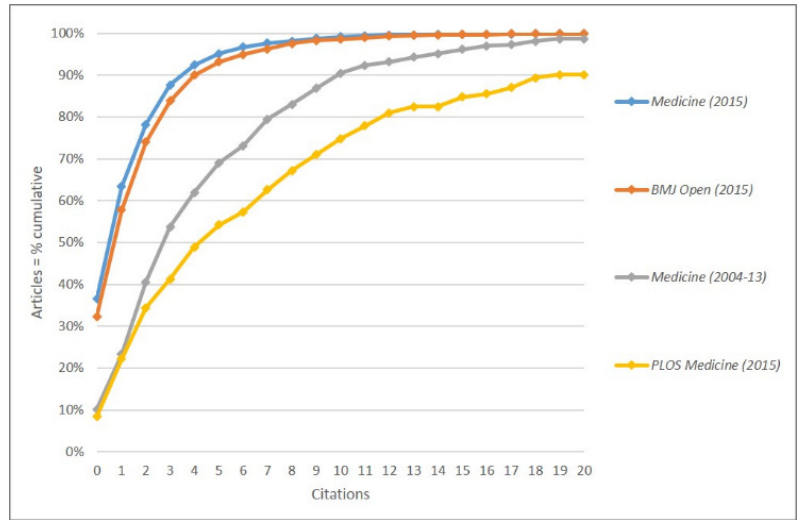
Figure 1. Cumulative citation frequency for Medicine (pre- and post-OAMJ transition), BMJ Open and PLOS Medicine.